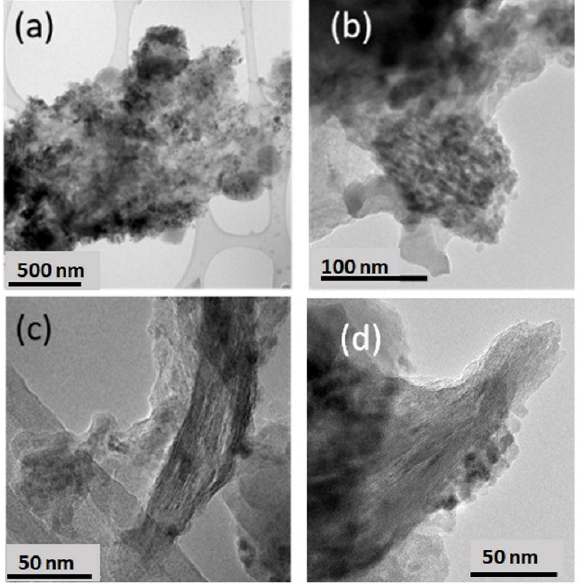
Figure 5. TEM images of raw HT sample ( a , c ) and after adding HCl ( b , d ) at different